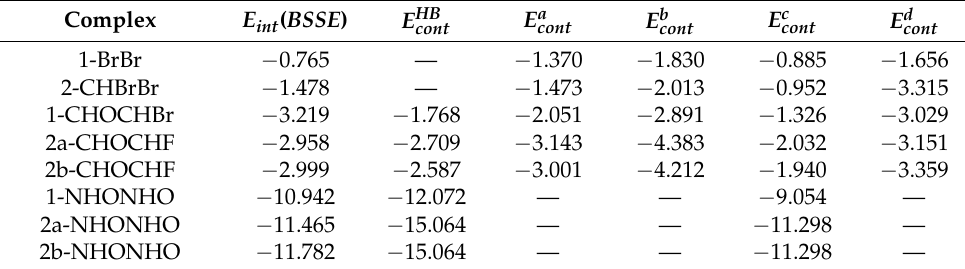
, in kcal/mol. The results were obtained with the cont b d E a E c cont E cont E cont cont cont E b cont = ∑ E HB + ∑ E b E c cont = ∑ E HB + ∑ E c E d cont = ∑ E HB + ∑ E d XB ; XB ; XB ; XB .